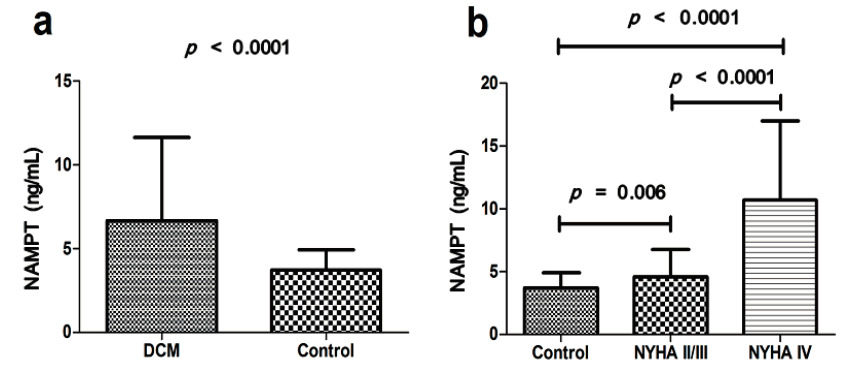
Figure 2. ( a ) Serum NAMPT levels were significantly increased in DCM blood samples ( p < 0.0001); and ( b ) Serum NAMPT levels significantly increased in NYHA IV class group than NYHA II/III class group and the controls (10.67 ± 6.23, 4.59 ± 2.17 and 3.71 ± 1.21 ng/mL, all p < 0.0001). Serum NAMPT levels in NYHA II/III class group significantly increased compared to controls (4.59 ± 2.17 and 3.71 ± 1.21 ng/mL, p = 0.006). Data are presented as means ± SD.